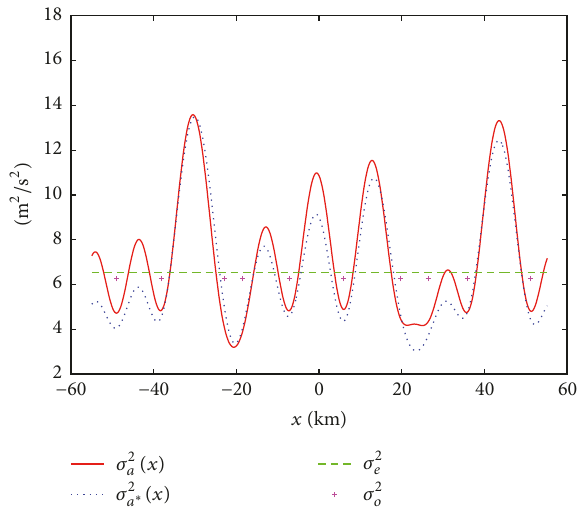
Figure 5: As in Figure 1 but for 𝑀 (=10) nonuniformly distributed coarse-resolution observations.